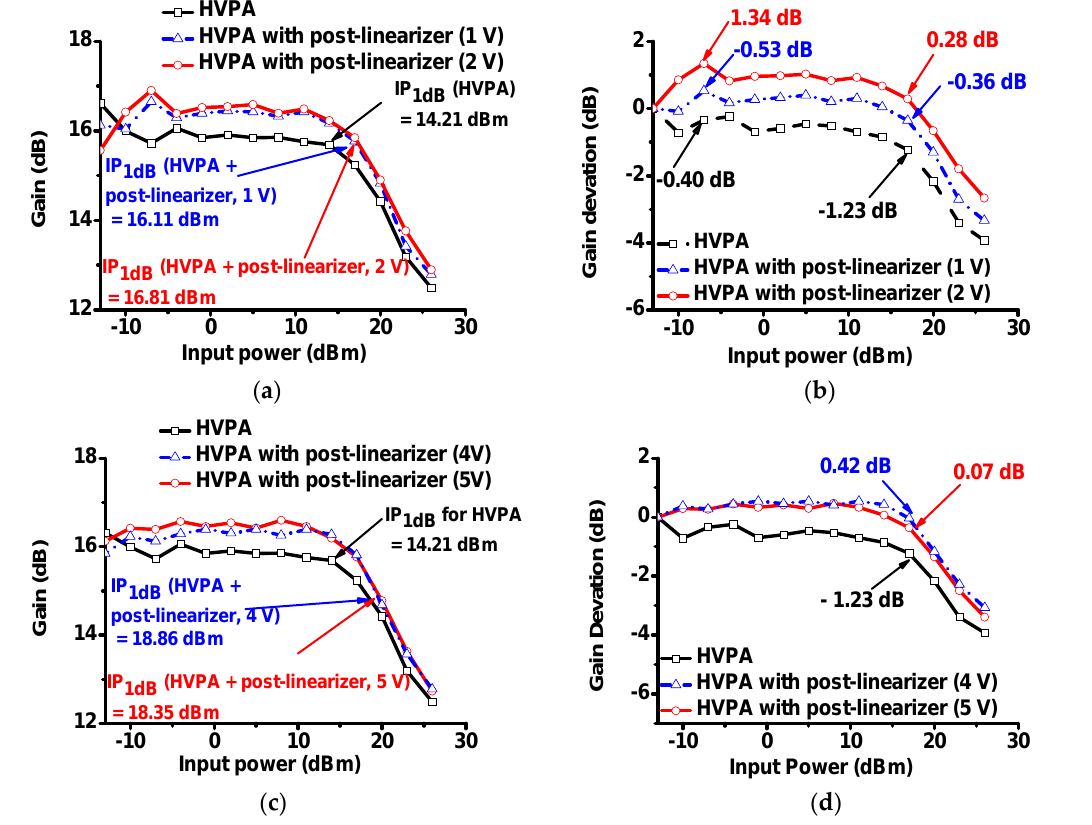
Figure 6. ( a ) Gain and ( b ) gain deviation vs. input power of the HVPA without the post ‐ linearizer (solid black lines) and HVPA with post ‐ linearizer with 1 V and 2 V DC applied voltages (solid red lines and dash ‐ dot blue lines, respectively); ( c ) Gain and ( d ) gain deviation vs. input power of the HVPA without the post ‐ linearizer (solid black lines) and HVPA with post ‐ linearizer with 4 and 5 V DC voltage applied (solid red lines and dash ‐ dot blue lines, respectively).